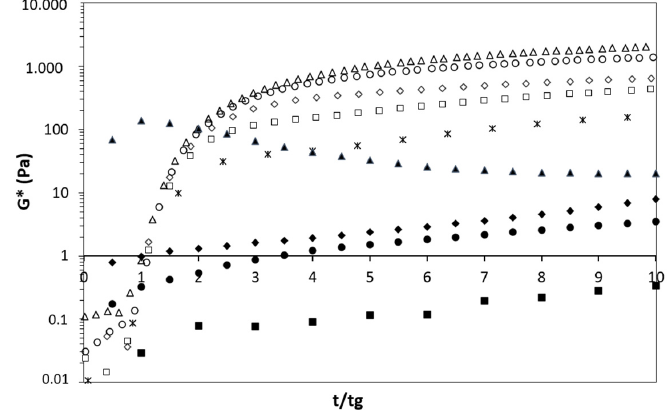
Figure 6. The evolution of the complex shear modulus (G*) as a function of reduced time (t/tg) for milk (open symbols) and mixed suspensions (closed symbols). The square, diamond, circle, and triangle markers represent the 5, 7, 9, and 11% ( w/w ) protein concentrations, respectively. The control milk sample is represented by the “x” symbol.